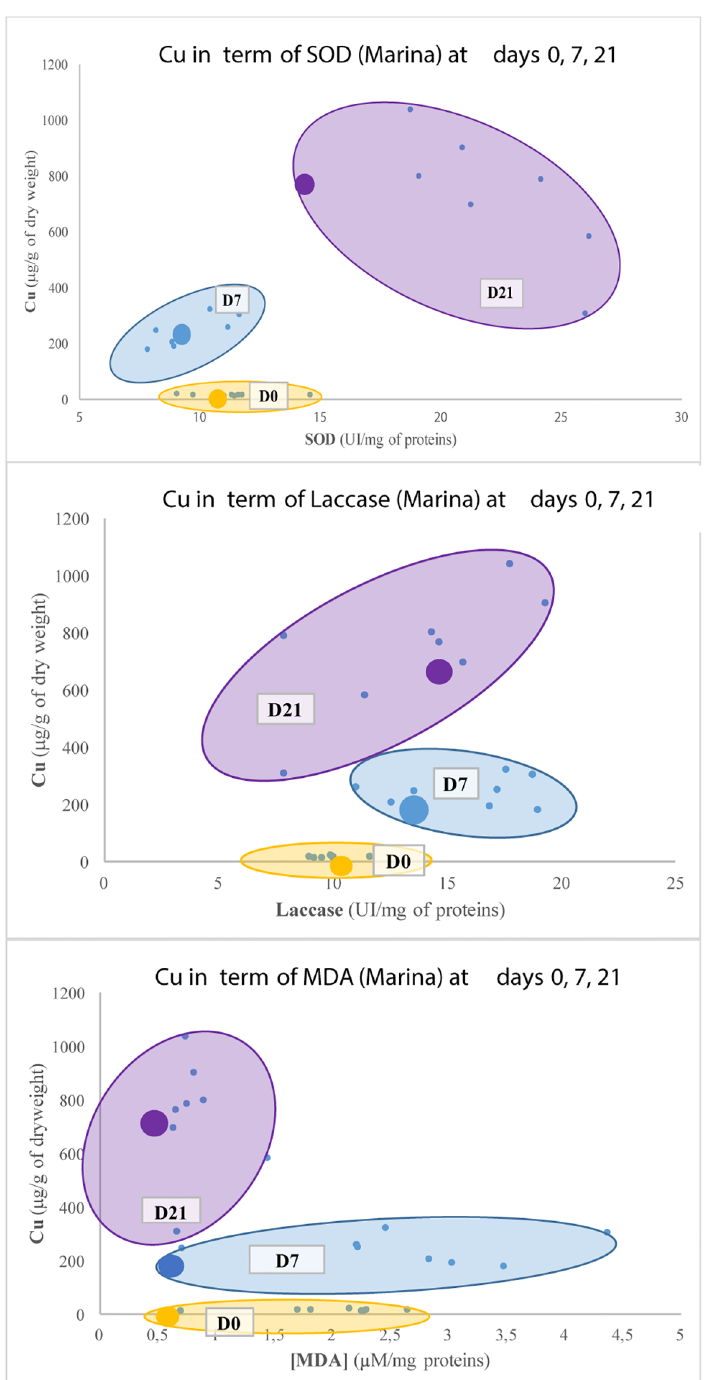
Fig 7. Specific pollution of Cu depending on SOD (struggle against ROS), Laccase (immunomodulation) and MDA (destruction of cell membranes) at the marina of La Rochelle.